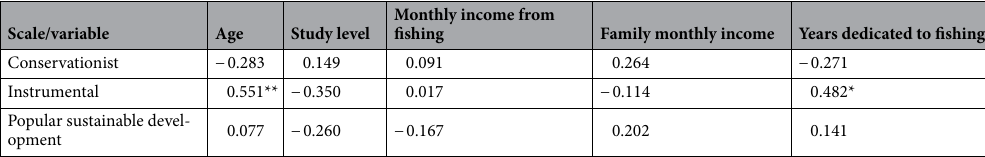
Table 4. Correlation between scale and sociodemographic variables. *p < 0.05, **p < 0.01, ***p <